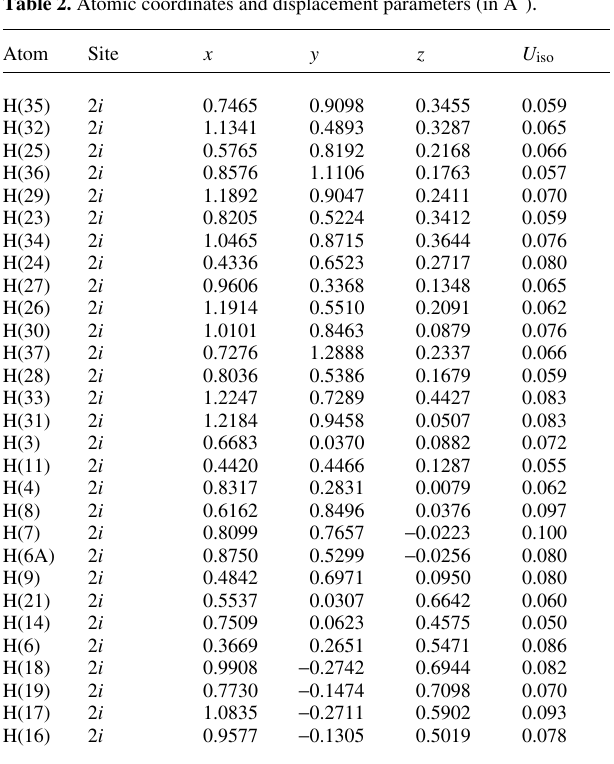
Table 2. Atomic coordinates and displacement parameters (in Å 2 )